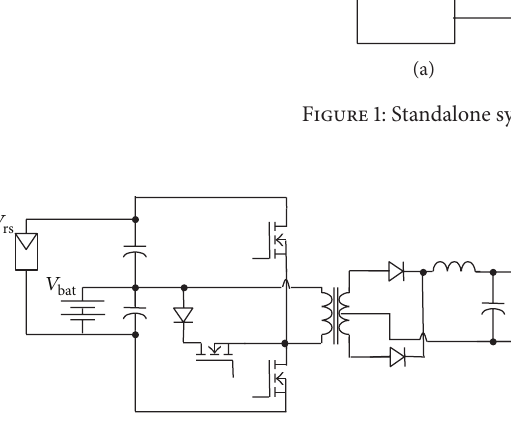
Figure 2: Three-port converter proposed in [8].